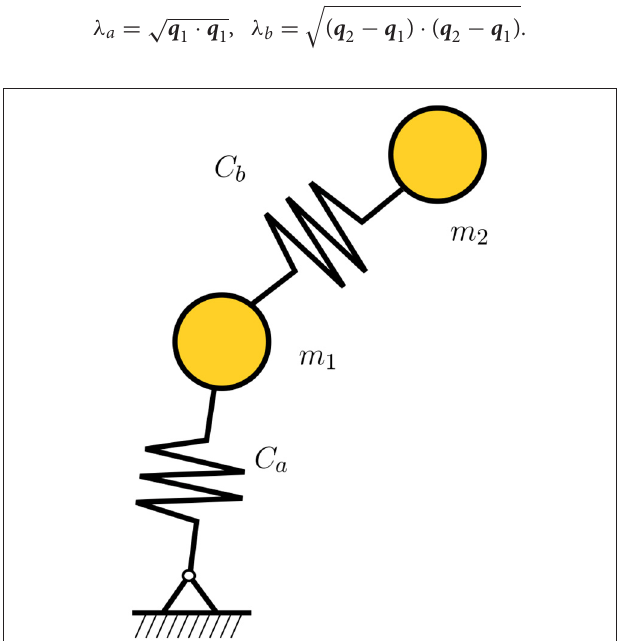
FIGURE 1 | Double thermal